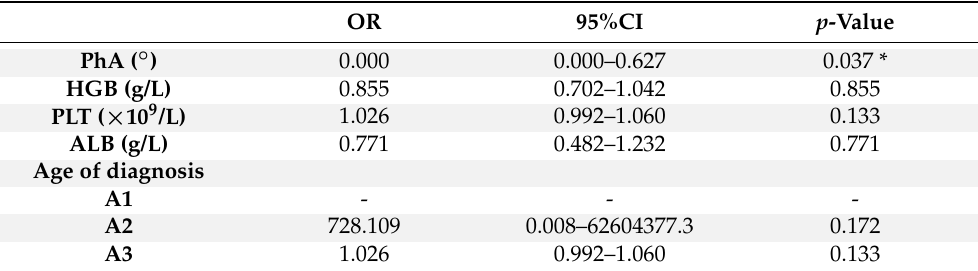
Table 6. Logistic regression analysis of predictors ’ degree of malnutrition based on GLIM criteria in women.